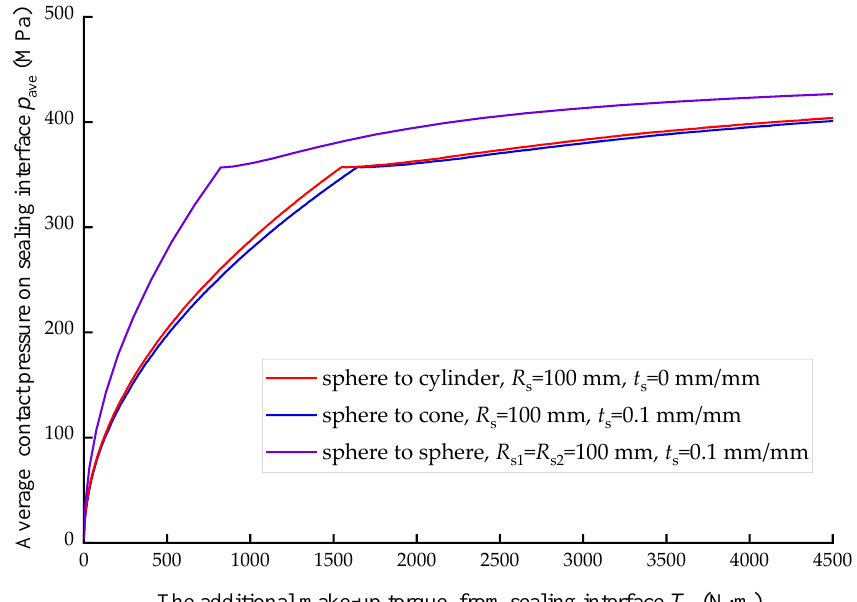
Figure 10. Effects of additional make-up torque from sealing interface on average contact pressure on sealing interface for three kinds of sphere-type premium connections.